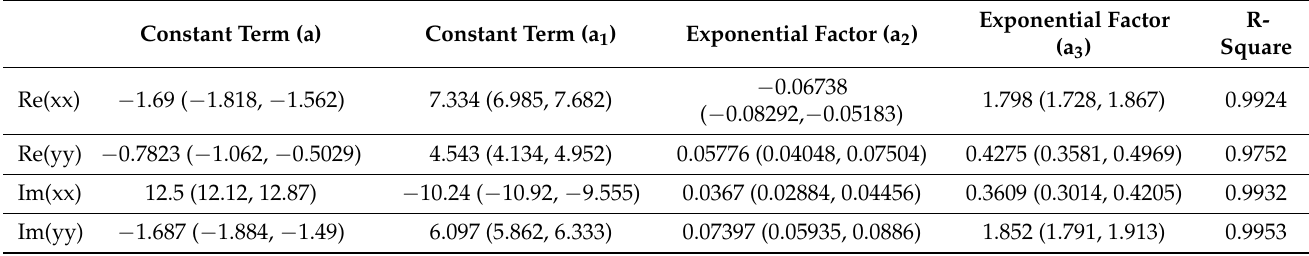
Table 1. Fit coefficients of the real and imaginary parts of the dielectric functions in the x and y orientations. Constant Term (a) Constant Term (a 1 ) Exponential Factor (a 2